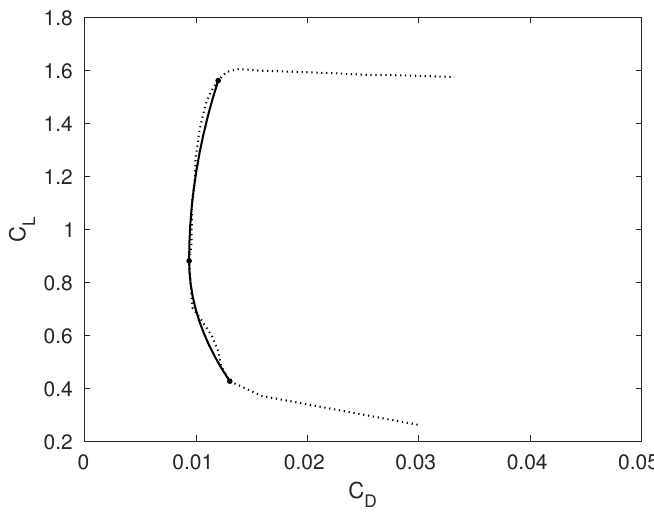
Figure 5. Drag polar of DAE11 at a Reynolds number of 500,000. Table 1. Mass and Center of Gravity (CG) breakdown of the Daedalus.